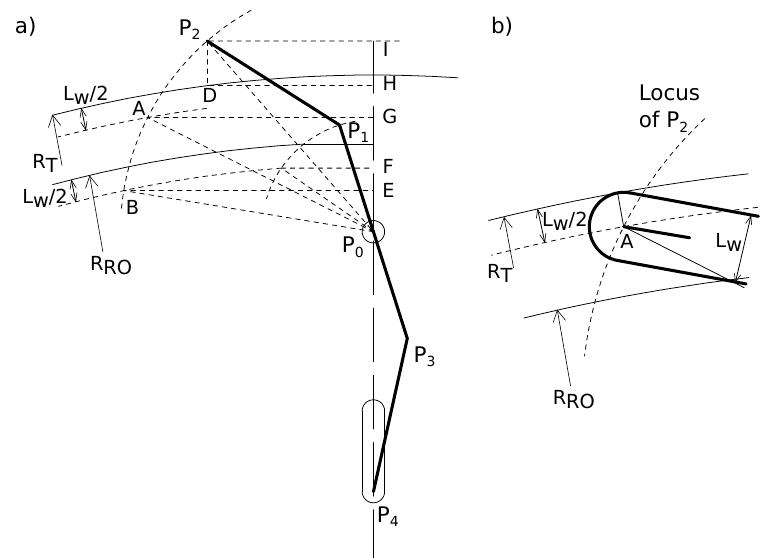
Figure 8. ( a ) Schematic view of chain 1; ( b ) detailed view of point